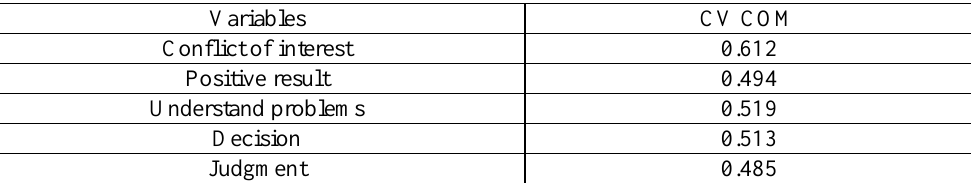
Table 5. Subscription index with cross